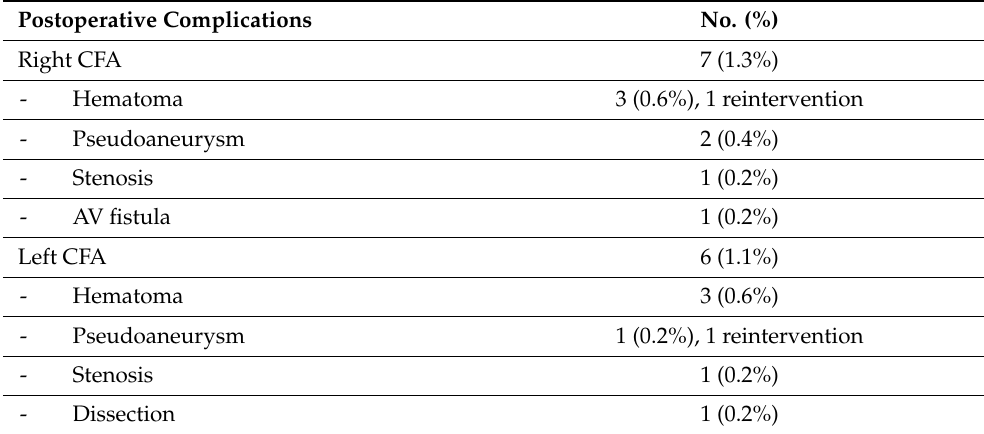
Table 4. Postoperative complications in relation to site access location. No. = number; CFA = common femoral artery; AV =